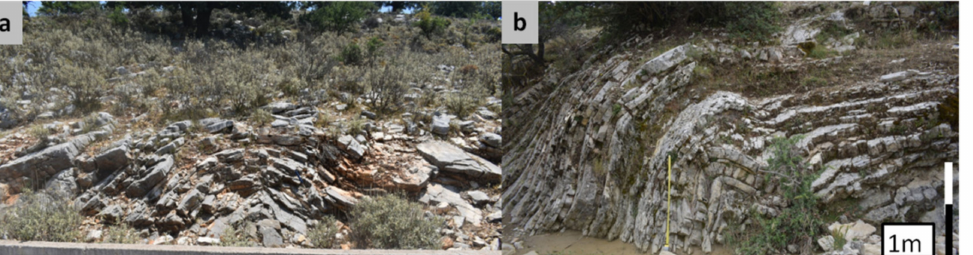
Figure 19. Internal synsedimentary deformations in a lower to upper Eocene carbonate succession,